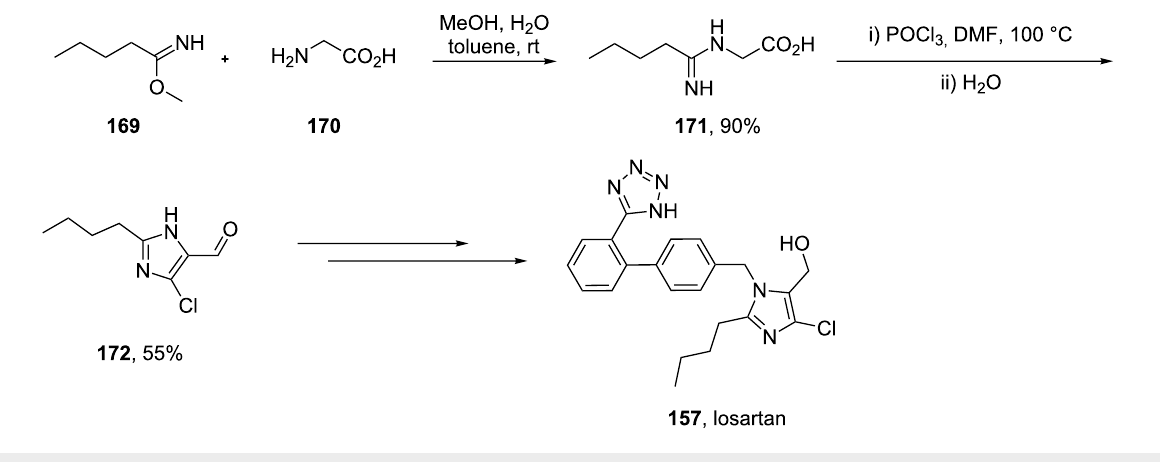
Scheme 34: Direct synthesis of the chlorinated imidazole in losartan.